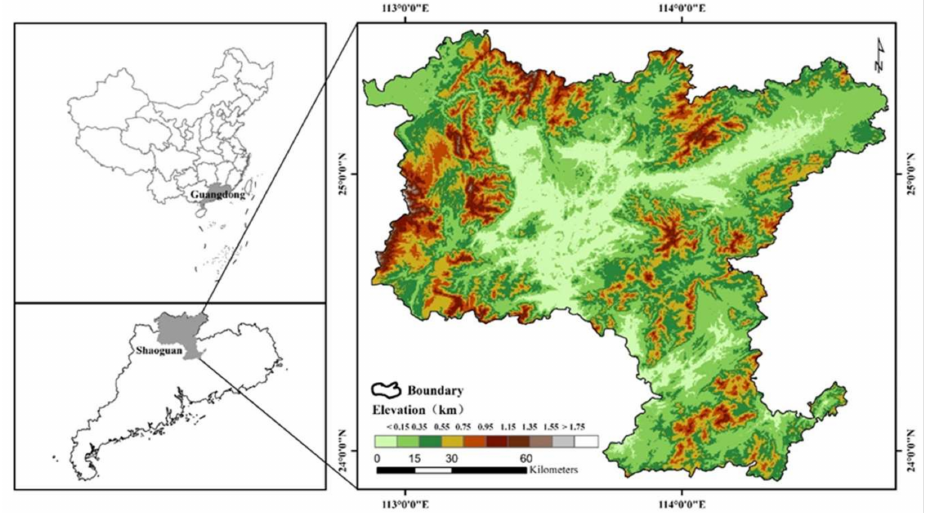
Figure 1. The geographical location of the northern area of Guangdong (China) and digital eleva- tion